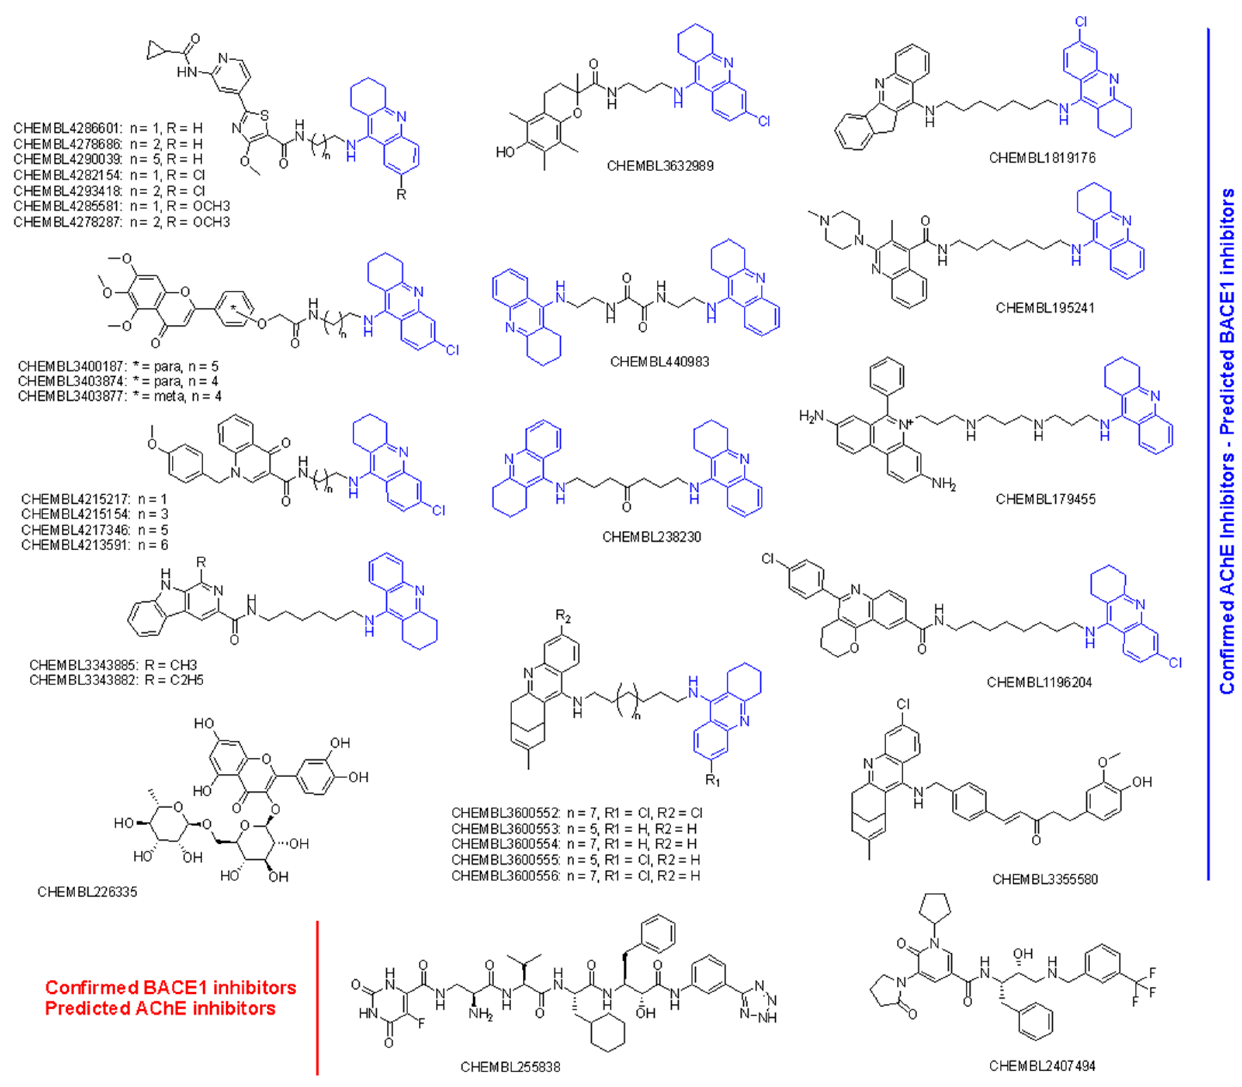
Figure 4. Chemical structures of AChE and BACE1 dual inhibitors screened by activity rules. The large number of tacrine derivatives are highlighted in blue. Table 5. AChE and BACE1 dual inhibitors screened by experimental and rule-based approaches.